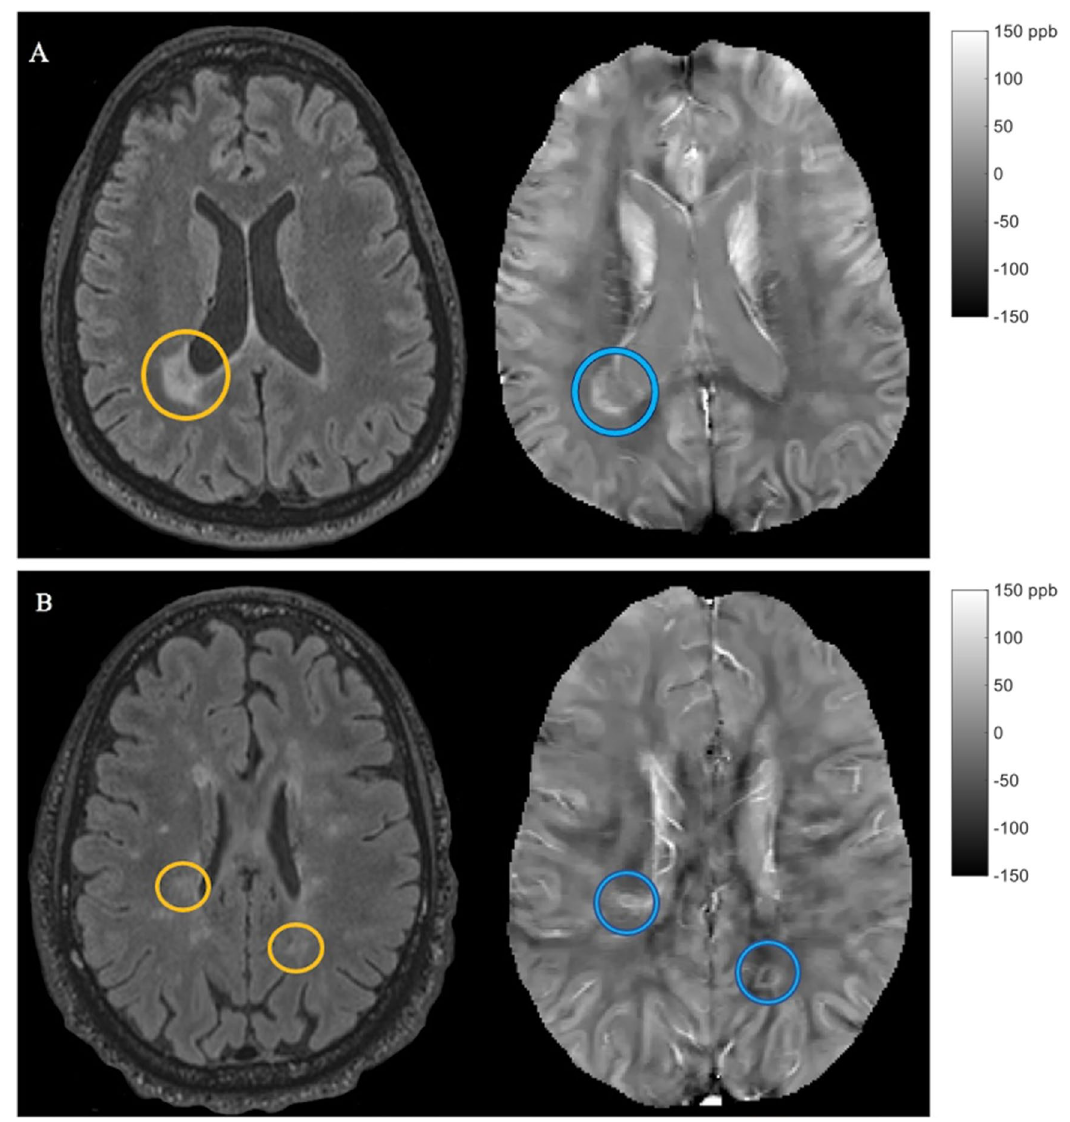
Figure 1. Examples of QSM rim+ lesions. Panels ( A ) and ( B ) represent slices of imaging for two separate patients. Within each panel, FLAIR is located on the left, and the corresponding slice of QSM is located on the right. In both panels ( A ) and ( B ), the lesion on FLAIR is located within an orange circle, while the corresponding lesion on QSM is located within a blue circle. These examples represent lesions with a complete rim on